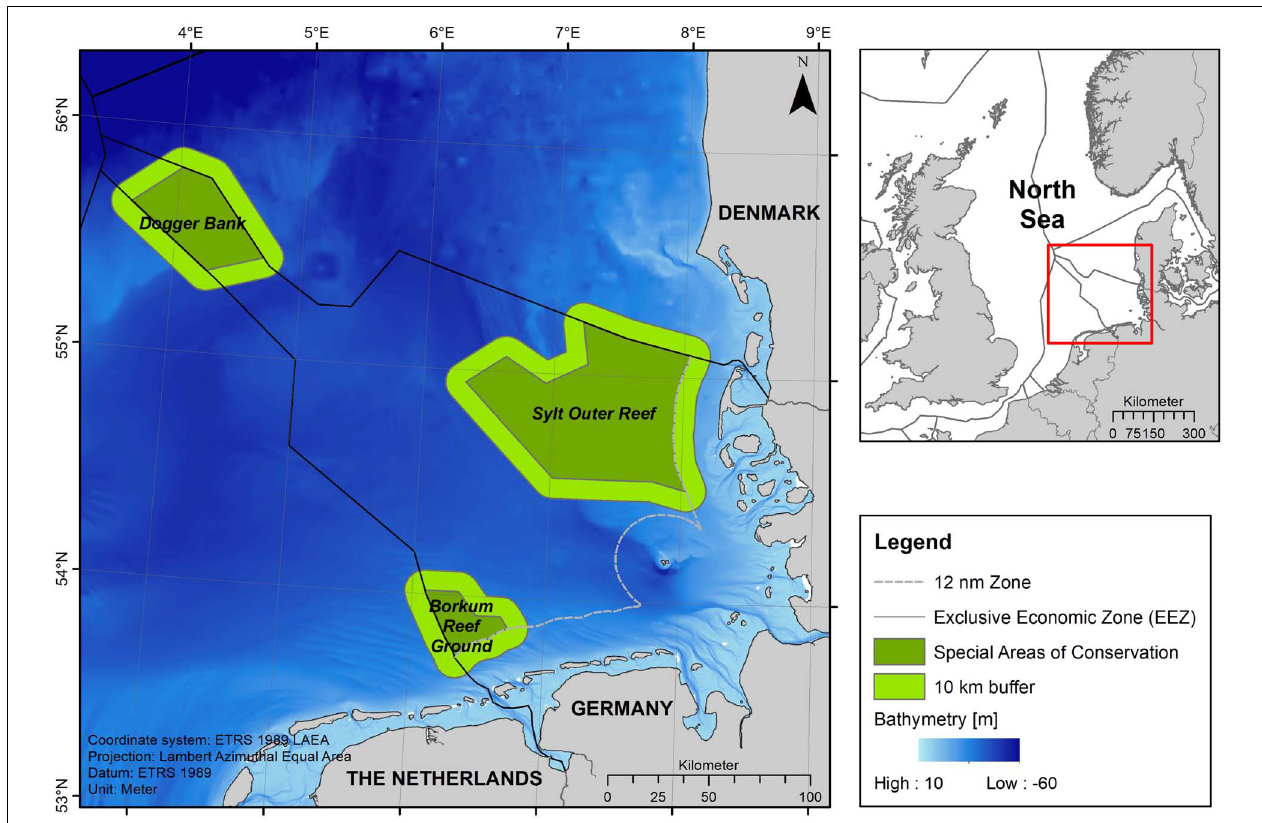
FIGURE 1 | Overview map (top right) of the study area in the German North Sea marked by a red box. Dark green areas in the map on the left illustrate the three SACs located in the German North Sea EEZ: Dogger Bank, Sylt Outer Reef and Borkum Reef Ground. Light green areas around the SACs indicate the 10 km buffer zone used during the analysis